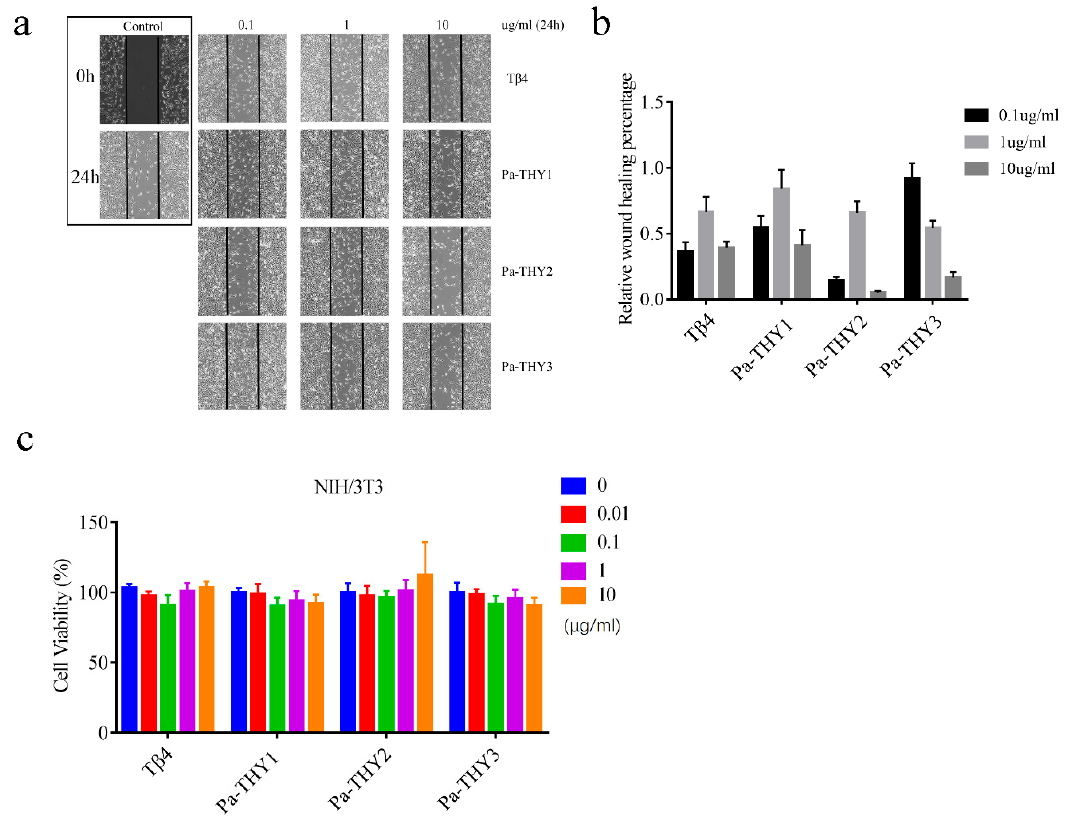
Figure 4. Effects of Pa-THYs on the migration and proliferation of fibroblasts. ( a ) Representative images of NIH/3T3 cells treated by T β 4 and Pa-THYs proteins (0, 0.1 μ g/mL, 1 μ g/mL and 10 μ g/mL). Magnification, ×200. ( b ) Quantification of wound-healing assays in NIH/3T3 cells treated with T β 4 and Pa-THYs proteins. The wound healing percentage was compared with control group. ( c ) Cell viability of NIH/3T3 cells treated by T β 4 and Pa-THYs proteins with different concentrations (0, 0.01 μ g/mL, 0.1 μ g/mL, 1 μ g/mL, and 10 μ g/mL).